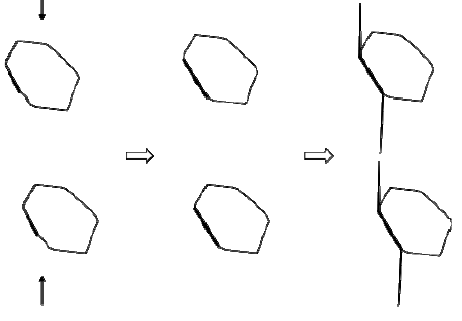
Figure 9. Microcrack growth under compression loading.